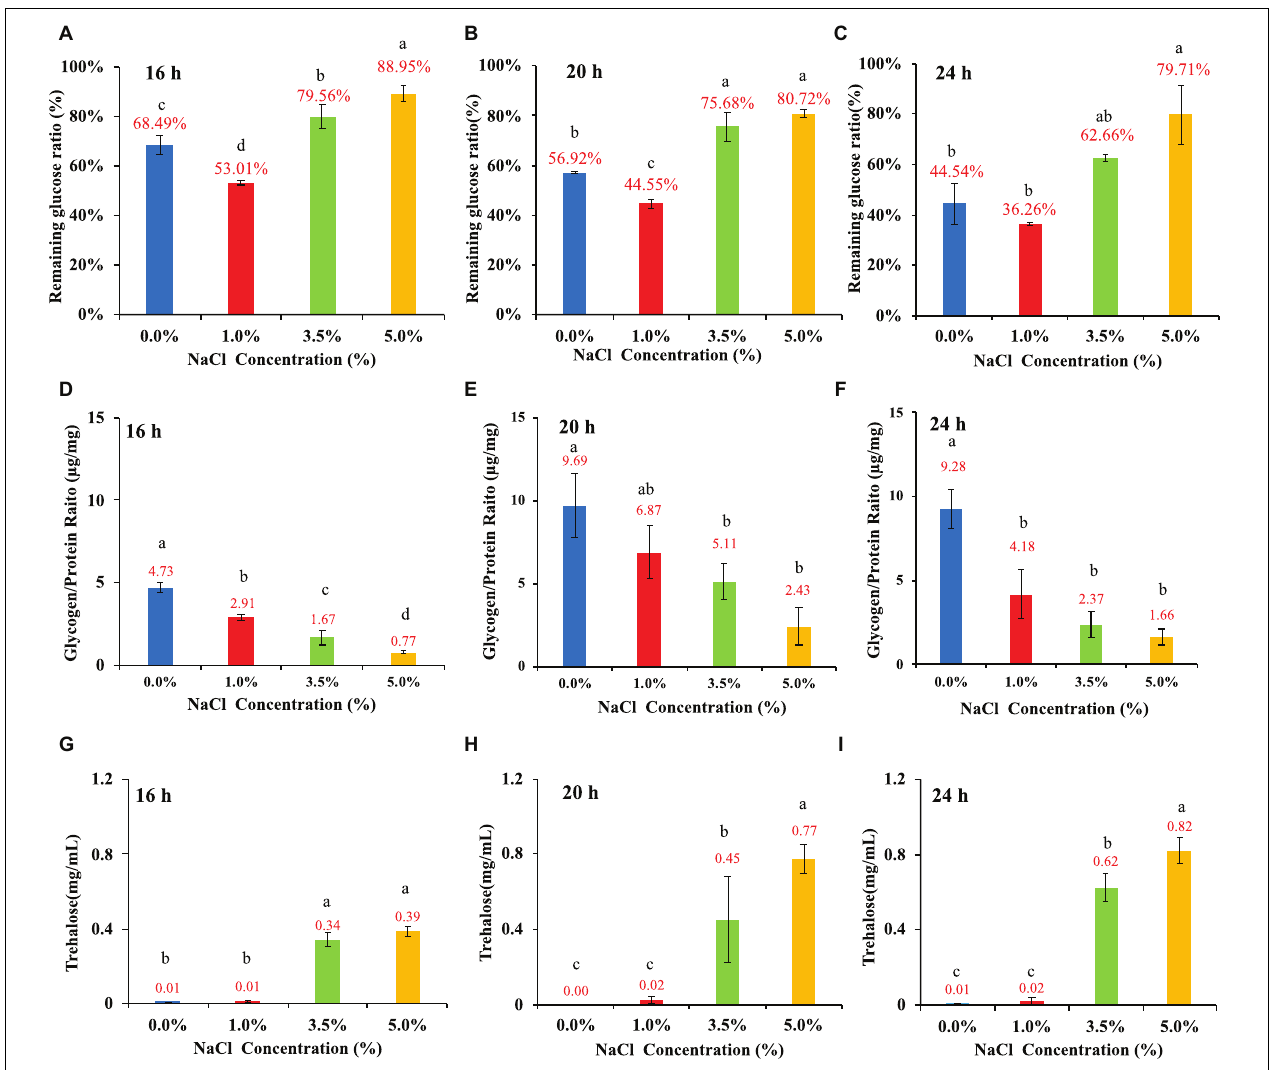
FIGURE 4 | Influences of NaCl concentrations (0, 1, 3.5, and 5%) on E. coli glucose consumption rate, glycogen accumulation, and trehalose content at three time points, that is, 16, 20, and 24 h. (A–C) Glucose consumption rate. (D–F ) Glycogen accumulation capacity. (G–I) trehalose content. Tukey’s Honestly Significant Difference (HSD) test was performed. Means denoted by a different letter indicated significant differences among groups ( P -value <